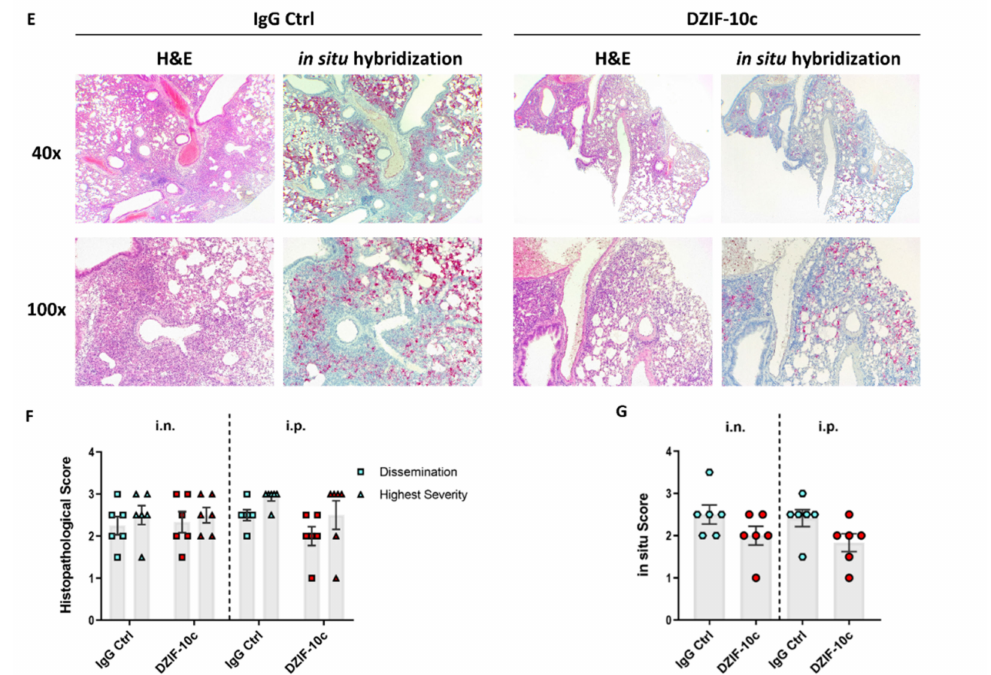
Figure 5. Viral load and histological analysis of hACE2-transduced BALB/c mice therapeutically treated with DZIF-10c. ( A ) Study plan for the therapeutic dose regimen. BALB/c mice were transduced with Ad_ACE2-mCherry three days before the challenge with SARS-CoV-2. Mice were treated i.n. or i.p. with 40 mg/KG body weight DZIF-10c or an IgG control antibody on days one and three post infection. On day four post infection, the animals were euthanized, and samples were collected. ( B ) Infectious SARS-CoV-2 titer in lung homogenates on day four post infection determined by the TCID 50 assay. ( C , D ) SARS-CoV-2 gRNA and sgRNA in lung homogenates on day four post infection determined by RT-qPCR. Error bars represent mean ± SEM. Statistical analyses were performed using Graph Pad Prism and the Mann–Whitney test. *: p ≤ 0.05; **: p ≤ 0.01. Dotted lines indicate the lower limit of detection. ( E ) Histopathological analysis of the lungs by H&E staining and in situ hybridization of viral RNA. Images were acquired at a magnification of 40 × or 100 × . ( F , G ) Quantification of histopathological scores for dissemination and highest severity of inflammation and dissemination of viral RNA. Error bars represent mean ± SEM. Statistical analyses were performed using Graph Pad Prism and the Mann–Whitney test. No statistical difference was observed in any